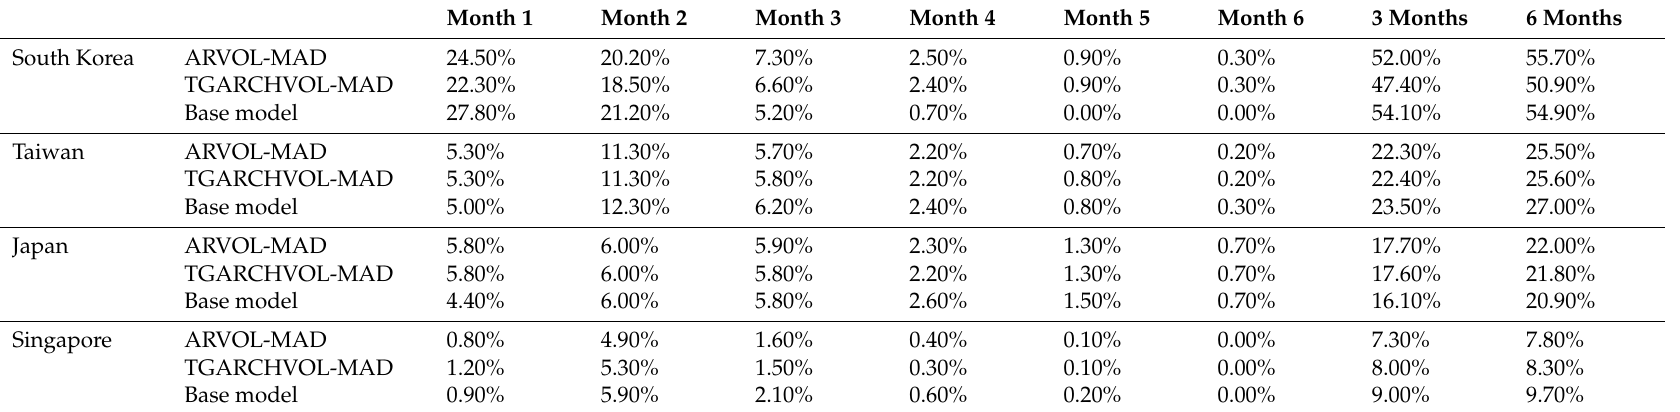
Table 7. Robustness check of the impulse response function